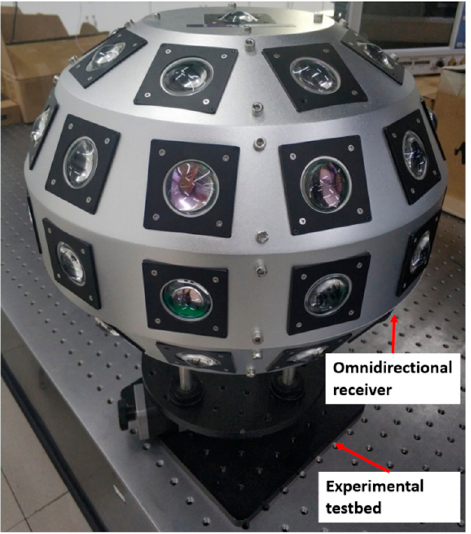
Figure 5. System model of omnidirectional reception.